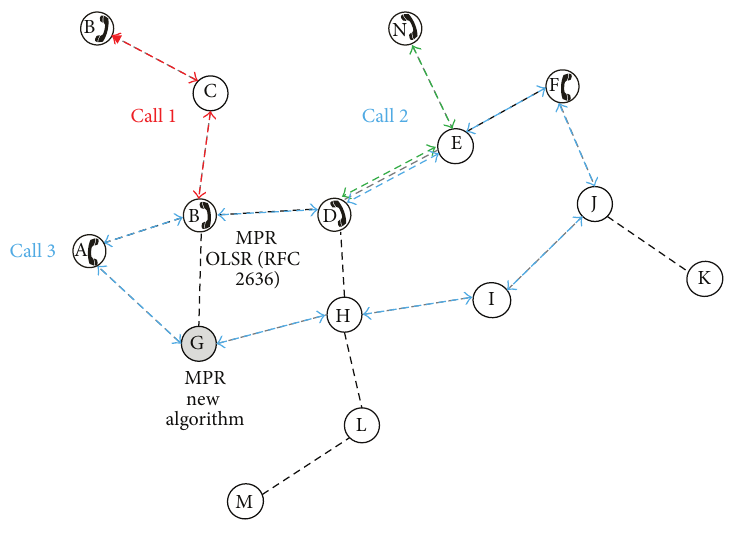
Figure 3: VoMAN scenario.